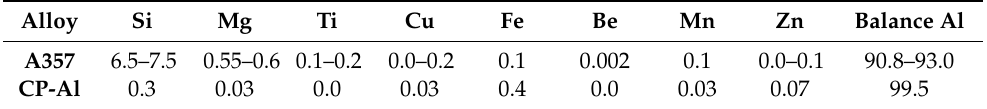
Figure 3. The ‘top-coil’ arrangement, showing the location of the high frequency microphone relative to the crucible. Table 2. Composition of alloys tested.